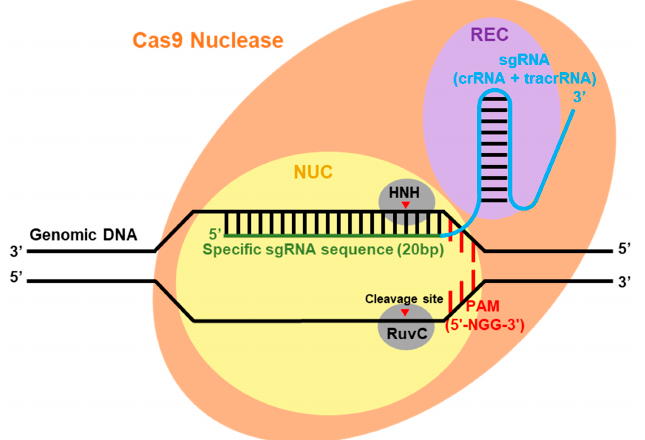
Figure 2. The CRISPR-Cas9 system: Cas9 structure and mechanism. Abbreviations: sgRNA, single guide RNA; crRNA, CRISPR RNA; tracrRNA, transactivation crRNA; PAM, protospacer adjacent motif; REC, recognition lobe; NUC, nuclease lobe.